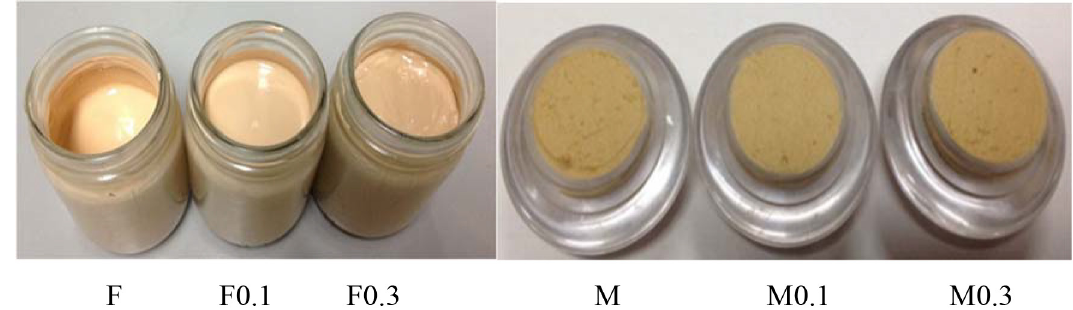
FIGURE 1 - Foundation and concealer mousse containing passion fruit